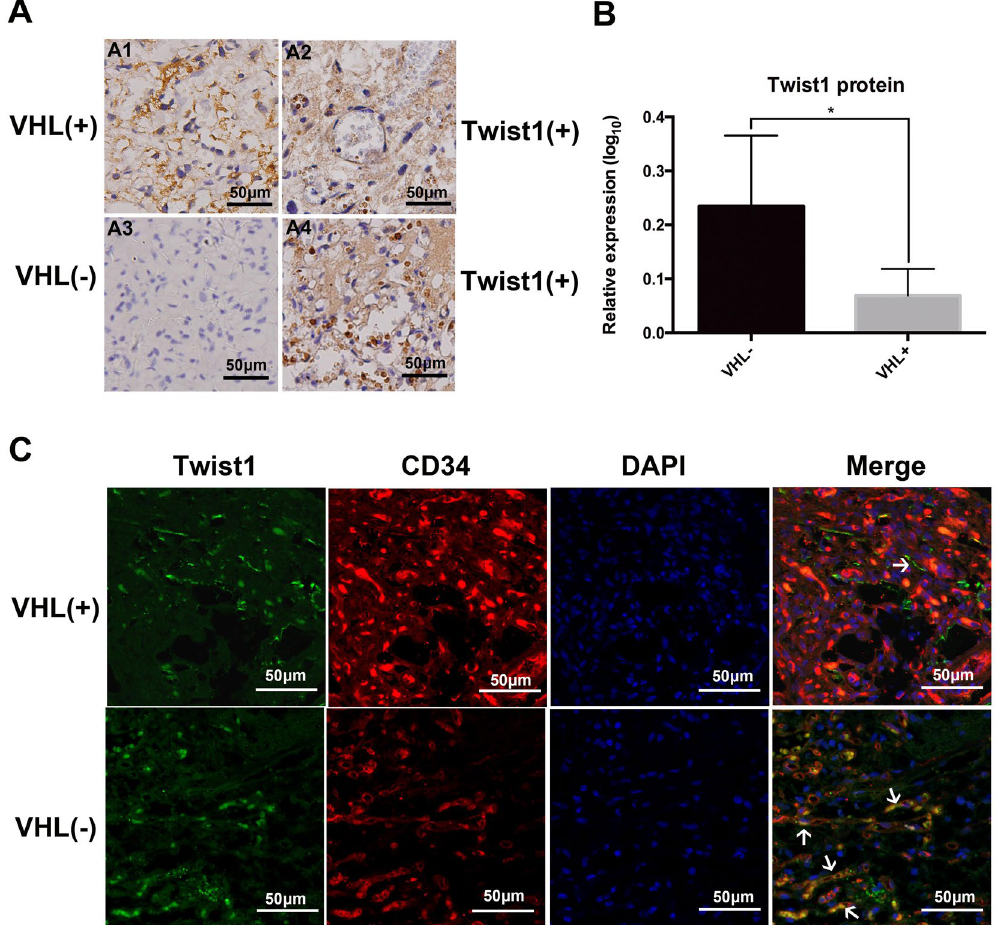
Figure 5. The correlation between VHL expression and Twist1 activation in HB tissues. ( A ) demonstrated that twist1 was over-expressed in VHL-negative HBs tissues (A3 and A4) compared with VHL-positive HBs tissues (A1 and A2) (Magnification × 400, bar = 50 μ m). ( B ) Statistical analysis was performed using unpaired Student’s t test, * P < 0.05. IF results ( C ) revealed that Twist1 and CD34 were co-expressed in a small subset of cells in HBs tissues (Magnification × 400, bar = 50 μ m). White arrows indicate the co-expressed